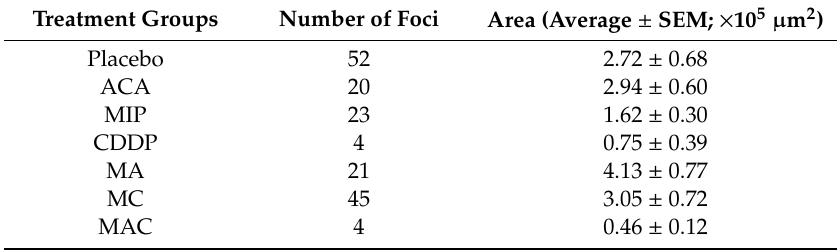
Table 2. Lung metastasis in BALB / c mice with breast cancer after